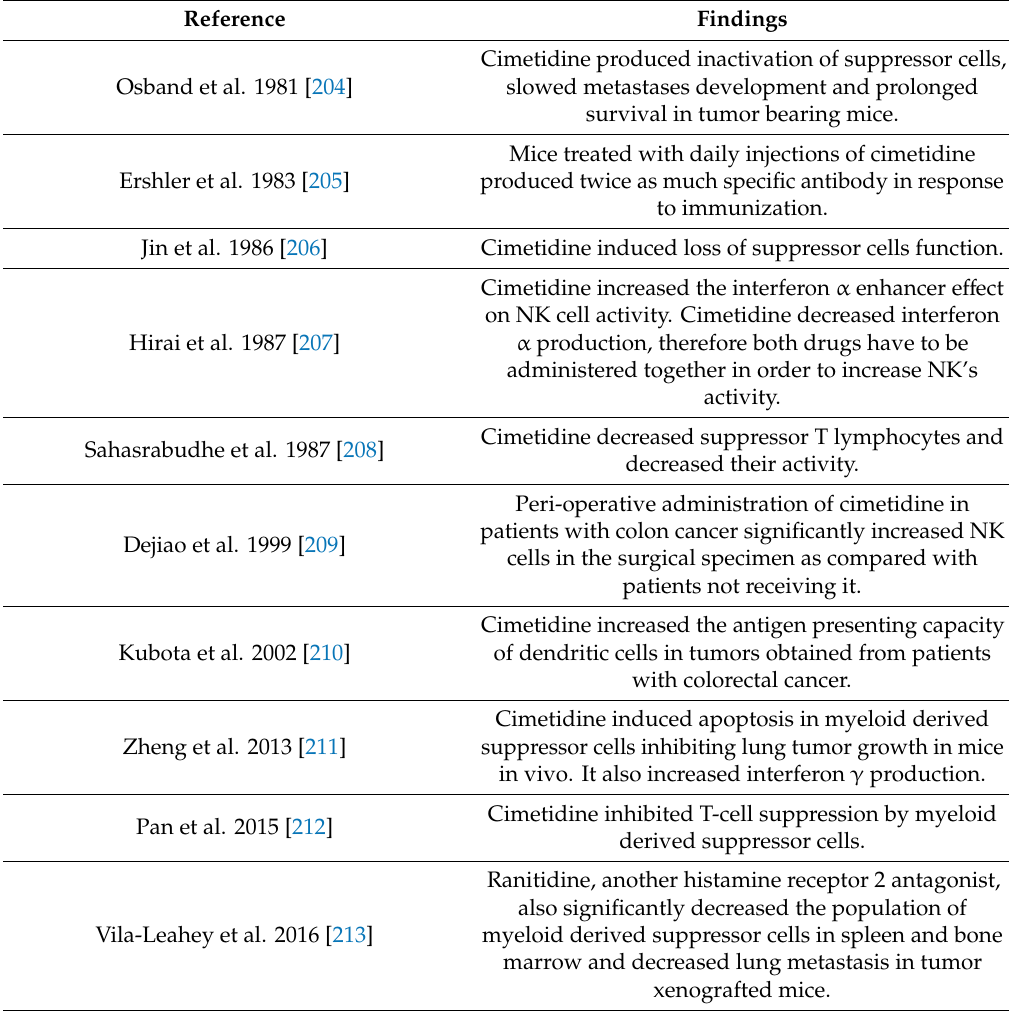
Table 2. Cimetidine’s immunologic e ff